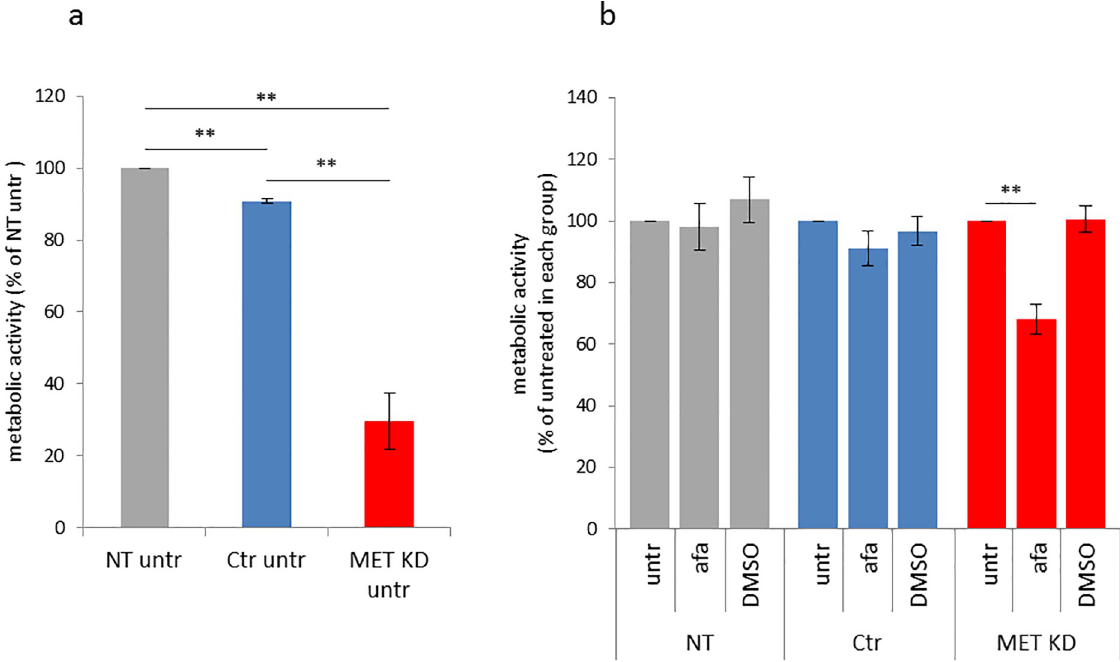
Fig 6. Afatinib reduces cell proliferation after MET knockdown. Hs746T cells were transfected with MET siRNA (MET KD) or control siRNA (Ctr). Non-transfected cells (NT) were analyzed in parallel. Cells were harvested and re-plated one day after transfection. The following day, cells were treated with 0.5 μ M afatinib or 0.05% DMSO for 72 hours. The mean of three biological experiments with standard deviation is shown. Data are shown as percent of NT untreated cells (a) or as percent of untreated cells of each group (NT, Ctr, MET KD) (b). T-test was used to compare the untreated cells between the groups and to compare afatinib-treated, DMSO-treated and untreated cells within each group (NT, Ctr, MET KD). Statistically significant differences are indicated by �� p < 0.01.